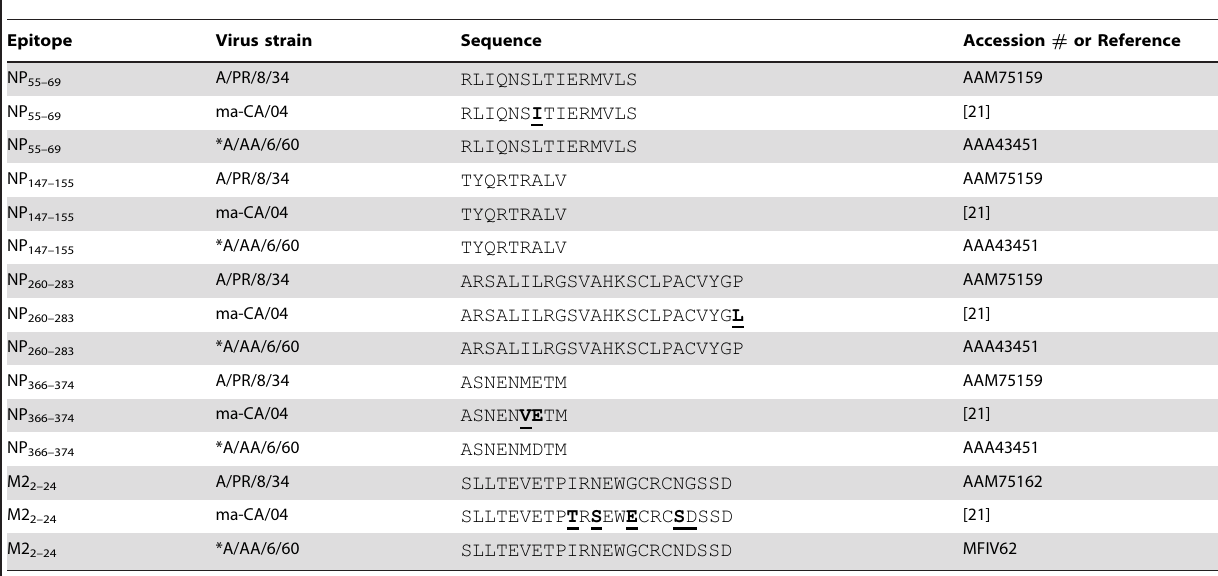
Table 1. Sequence variation in vaccine and challenge virus